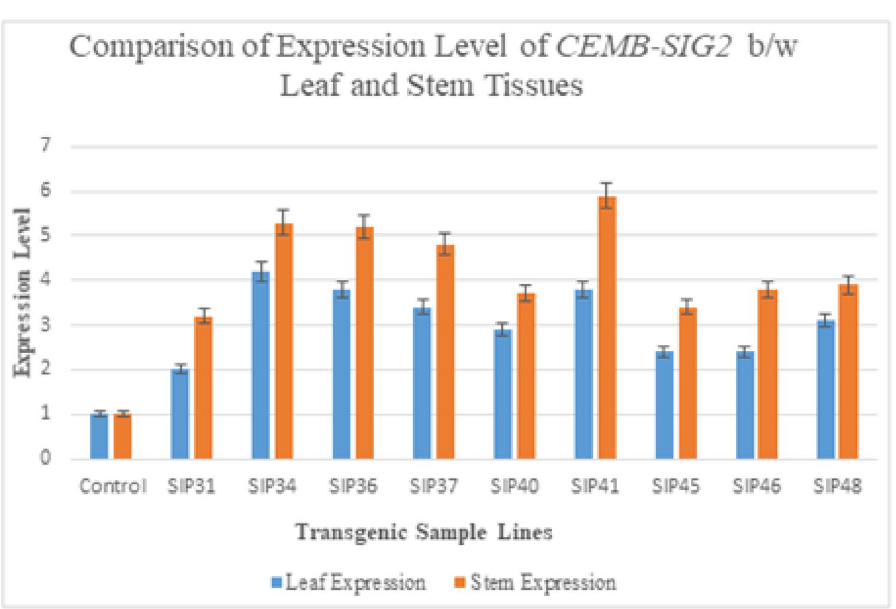
Figure 7. Comparative expression patterns of ThSyGII ( CEMB-SIGII ) gene in leaves and stalks. Blue bars exhibited ThSyGII expression levels in leaves while orange bars indicated ThSyGII expression levels in culm tissues (p <